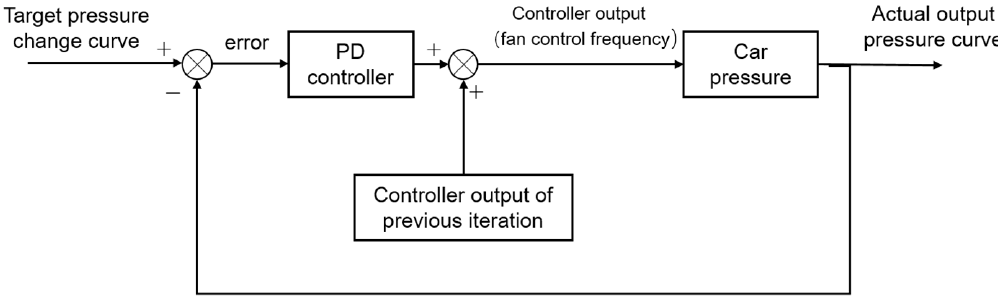
Figure 7. PD ‐ ILC controller of the air pressure compensation system. Figure 7. PD-ILC controller of the air pressure compensation